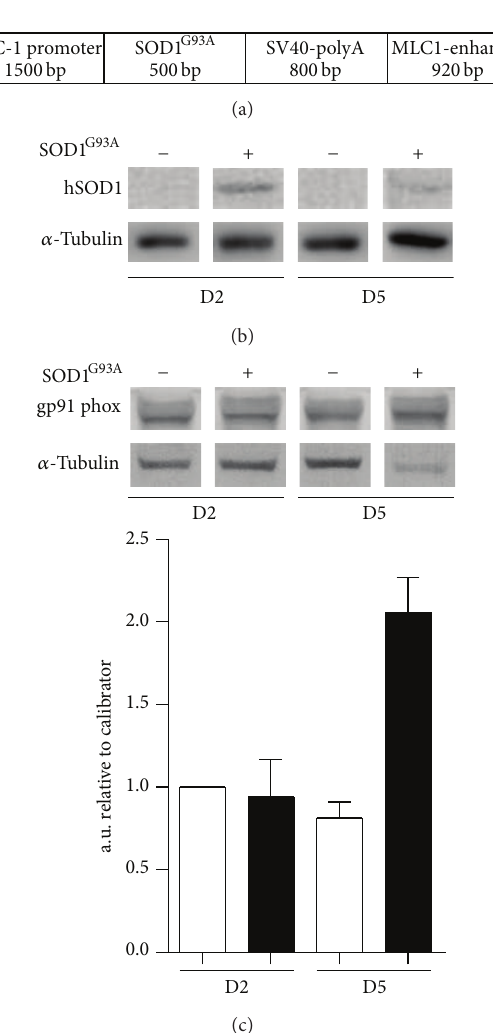
Figure 1: Characterization of C2C12 MLC/SOD 1 G 93 A . (a) Schematic representation of MLC/SOD 1 G 93 A construct. (b) Western blot anal- ysis for mutant human SOD 1 G 93 A protein in C2C12 and C2C12 MLC/SOD 1 G 93 A at different time points during differentiation. (c) Upper panel shows representative western blot analysis of gp91phox expression in C2C12 and C2C12 MLC/SOD 1 G 93 A cells. Lower panel shows the relative densitometric analysis of C2C12 (white bars) and C2C12 MLC/SOD 1 G 93 A (black bars). D2 and D5 referred to days of culture in differentiation condition. Data are represented as mean ±